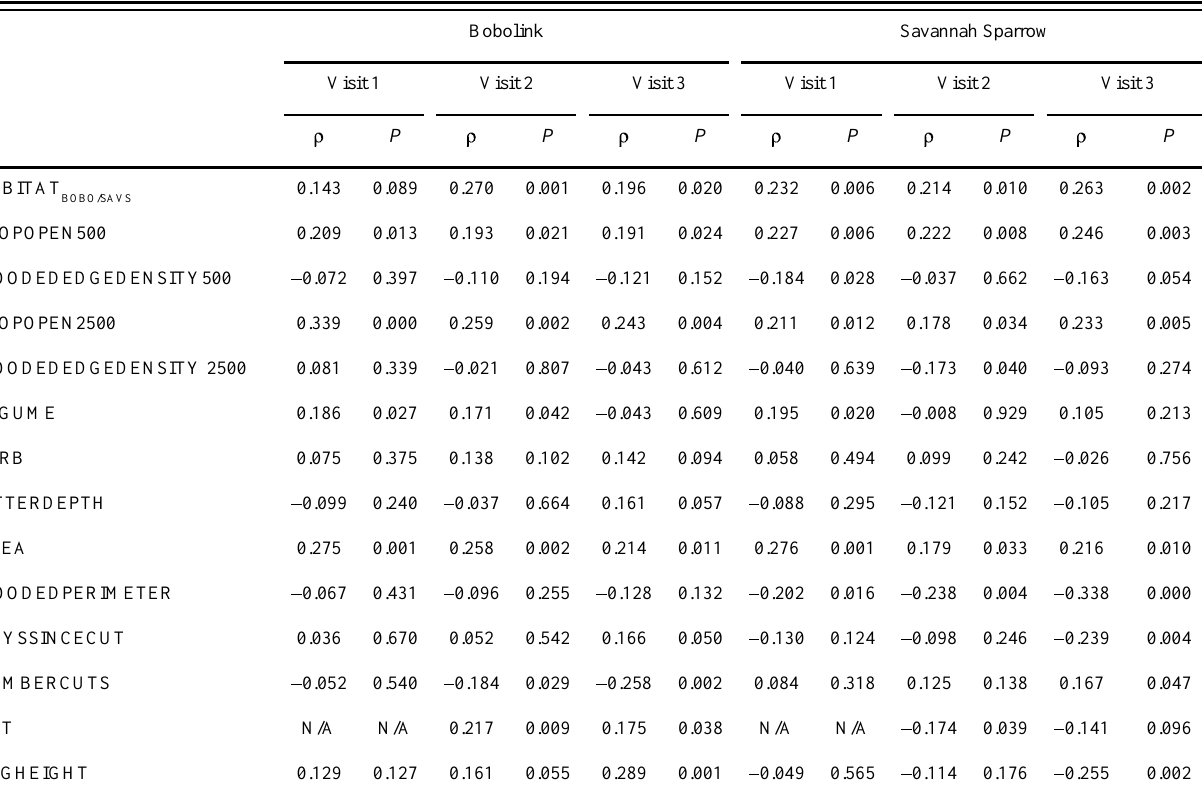
Table 3. Spearman correlation coefficients ( ) for male Savannah Sparrow and male Bobolink abundance on agricultural fields and habitat variables from the Champlain Valley of Vermont and New York over three sampling occasions